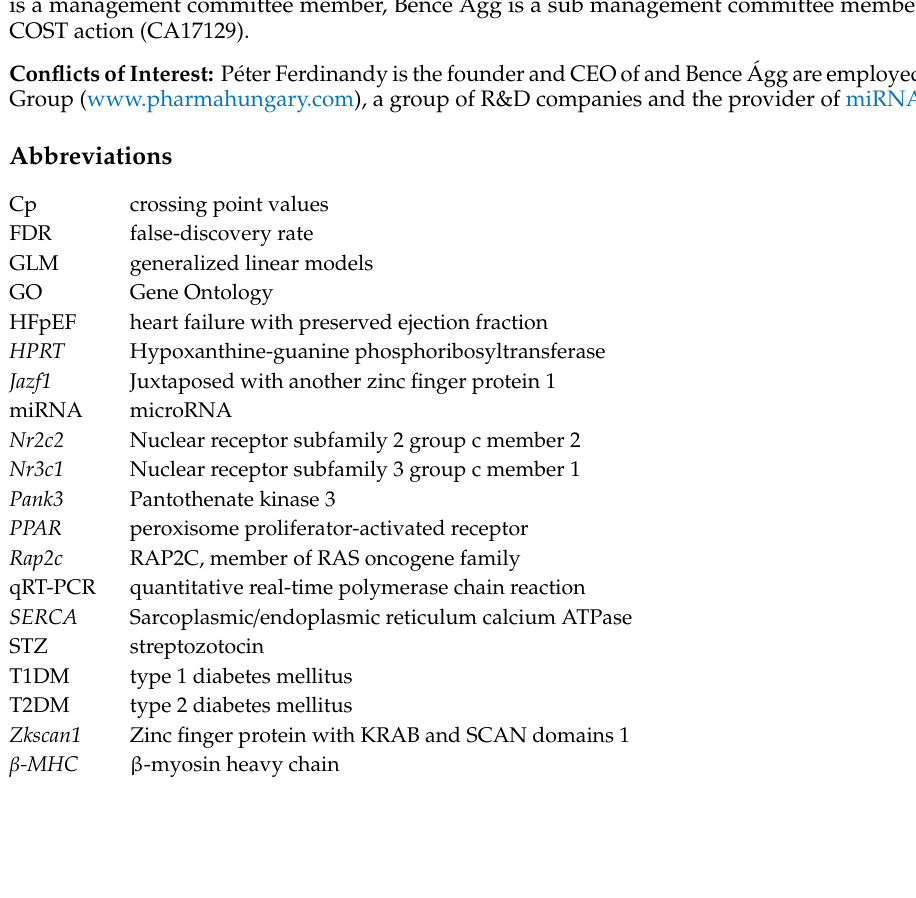
Table S1: Predicted miRNA-target interaction list, Table S2: Detailed results of Gene Ontology enrichment analysis of the predicted targets of di ff erentially expressed